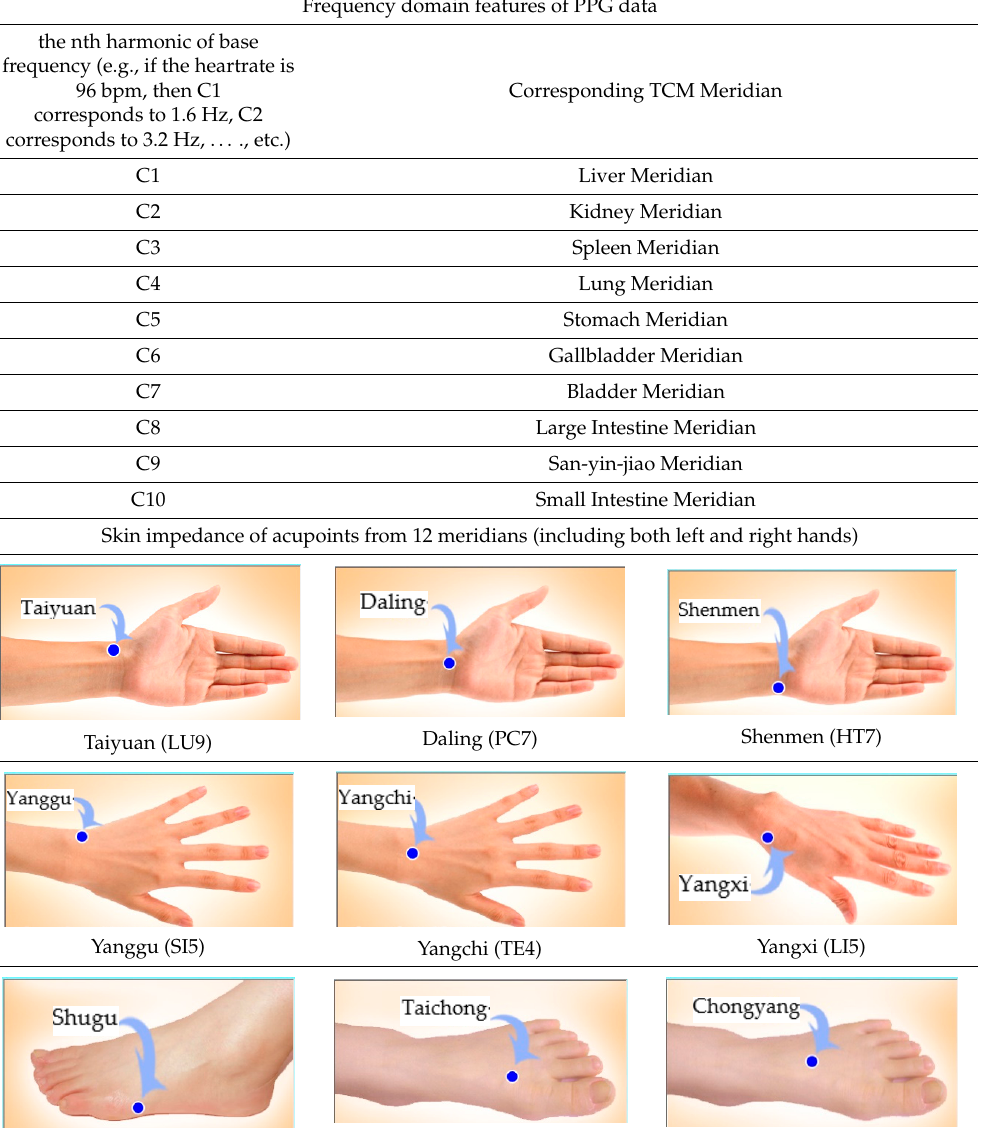
Table 1. Cont. Time-Domain Features of PPG Data (As Shown in Figure 5) Frequency domain features of PPG